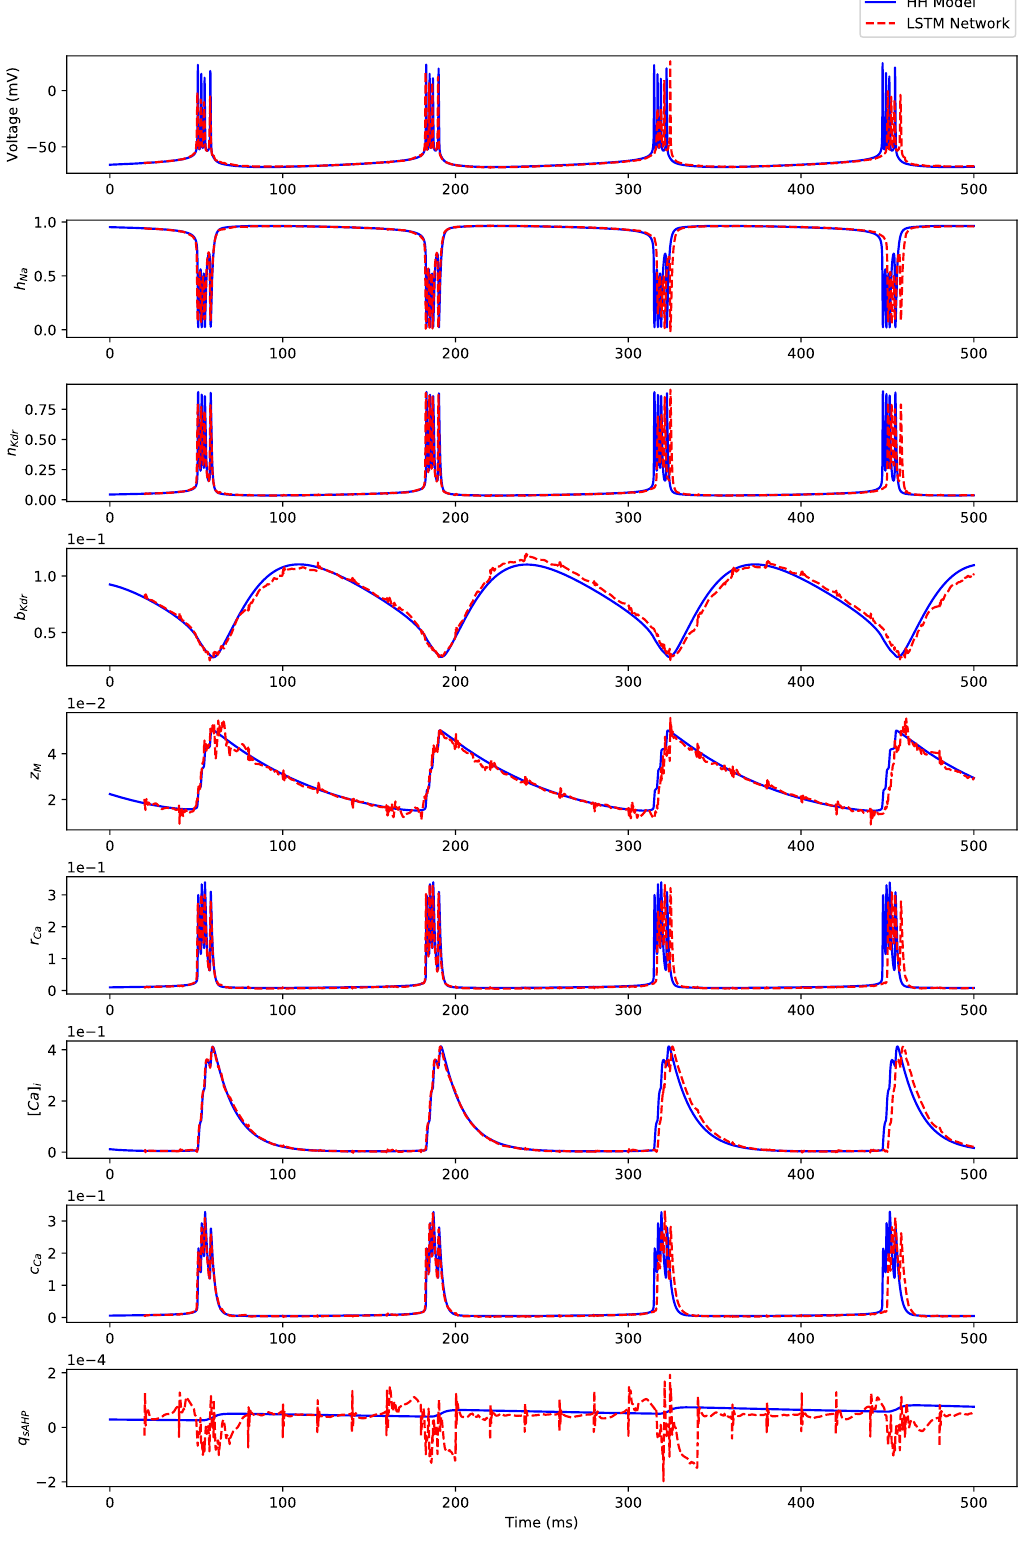
Figure A14. Comparison between the Hodgkin-Huxley model (“HH Model”) states’ dynamics and the iterative predictions of states’ dynamics using the 200 timesteps predictive horizon-based deep LSTM neural network (“LSTM Network”) in response to I = 0.5